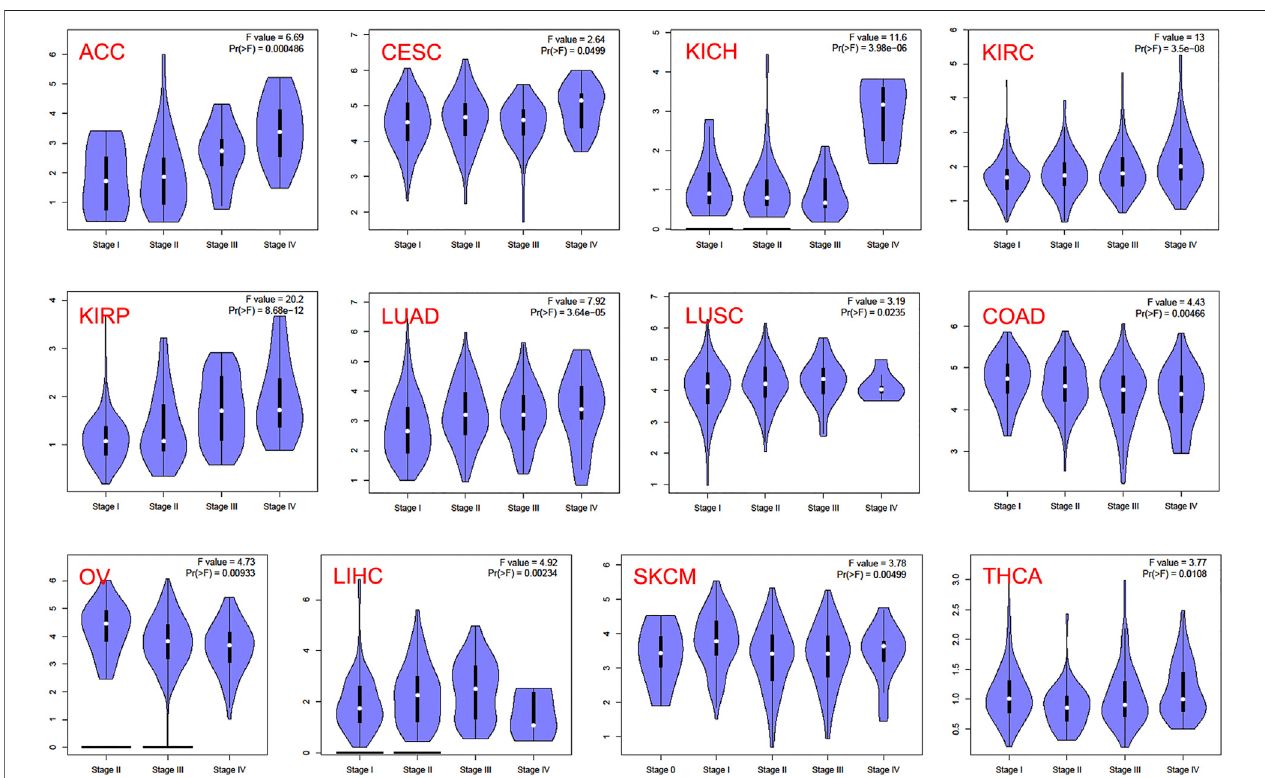
FIGURE 3 | CCNA2 expression of various pathological stages in various cancers.